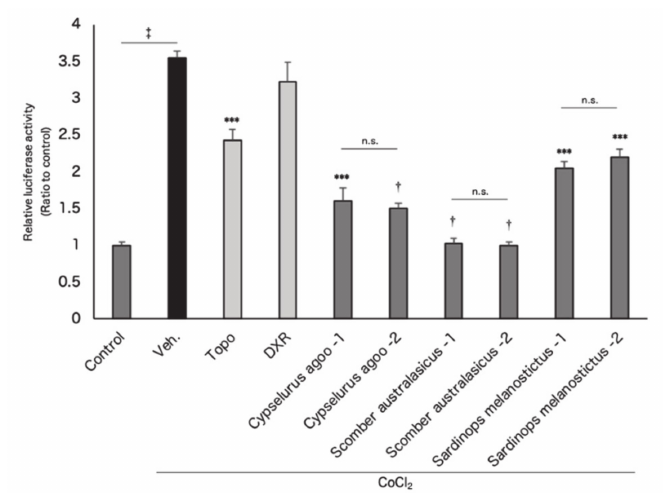
Figure A2. Oil components of Fish ingredients show no e ff ect on HIF activity in vitro. HIF-reporter luciferase assay was performed using 661W ( n = 3). C. agoo , S. australasicus , and S. melanostictus ingredients were extracted with ( fish -2) or without ( fish -1) n -Hexane. Note that oil-free ingredients showed no change in HIF inhibitory e ff ect compared with the ingredients containing oil component. *** p < 0.001, † p < 0.0001, ‡ p < 0.00001 compared with CoCl 2 -Veh. Error bars indicate mean plus